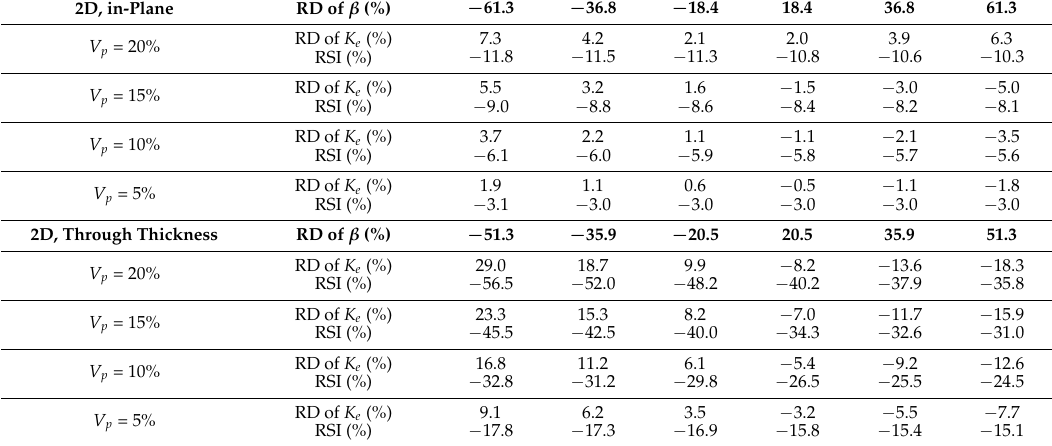
Table 4. Sensitivity analysis of the pore shape factor for 2D woven and 3D braided composites.